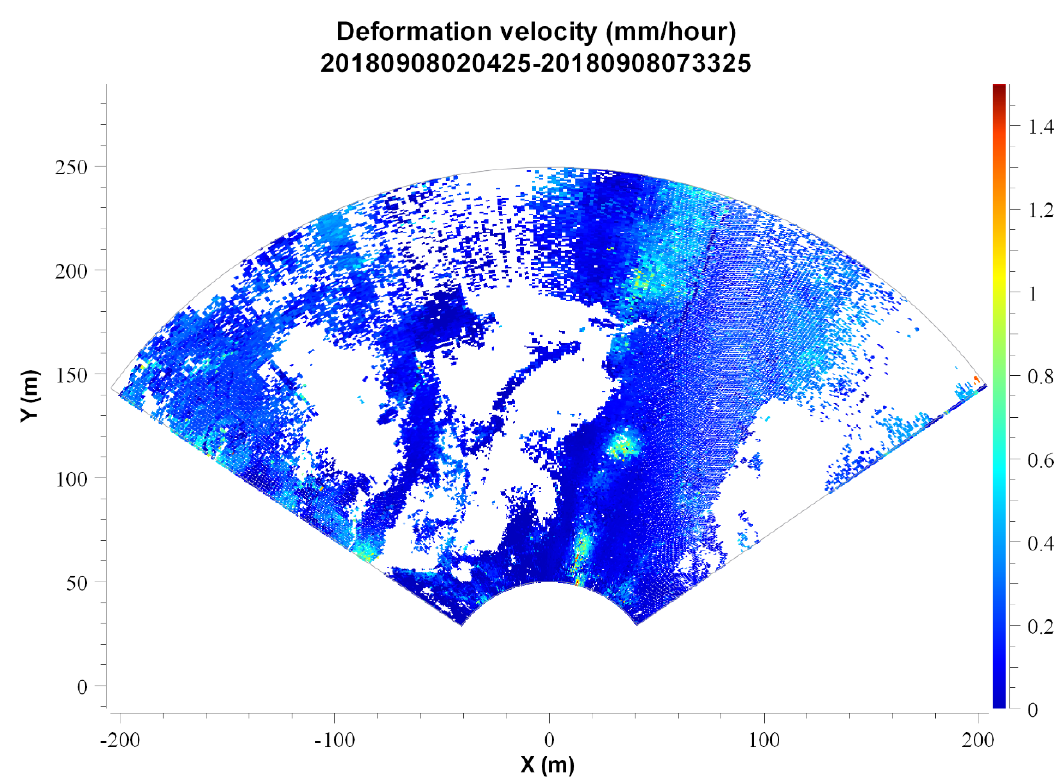
Figure 8. The deformation velocity rate map.